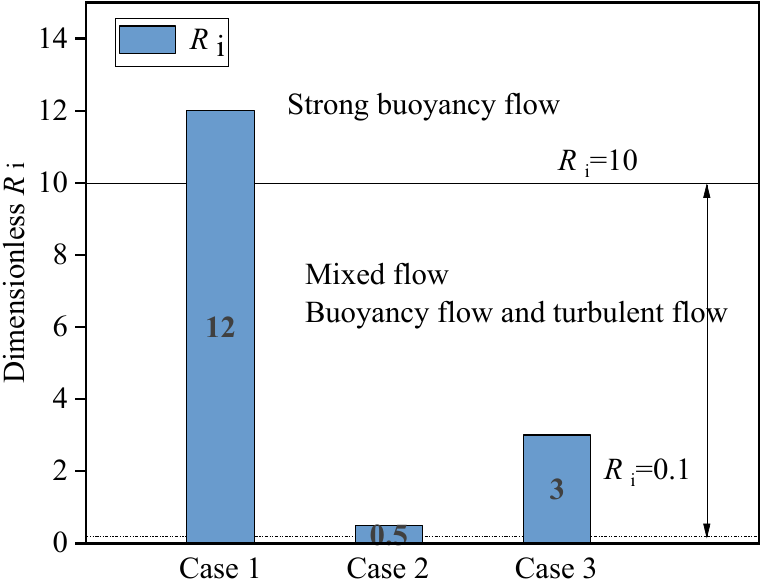
Figure 6. Distribution of Richardson number and corresponding airflow states in Case 1, Case 2, and Case 3.